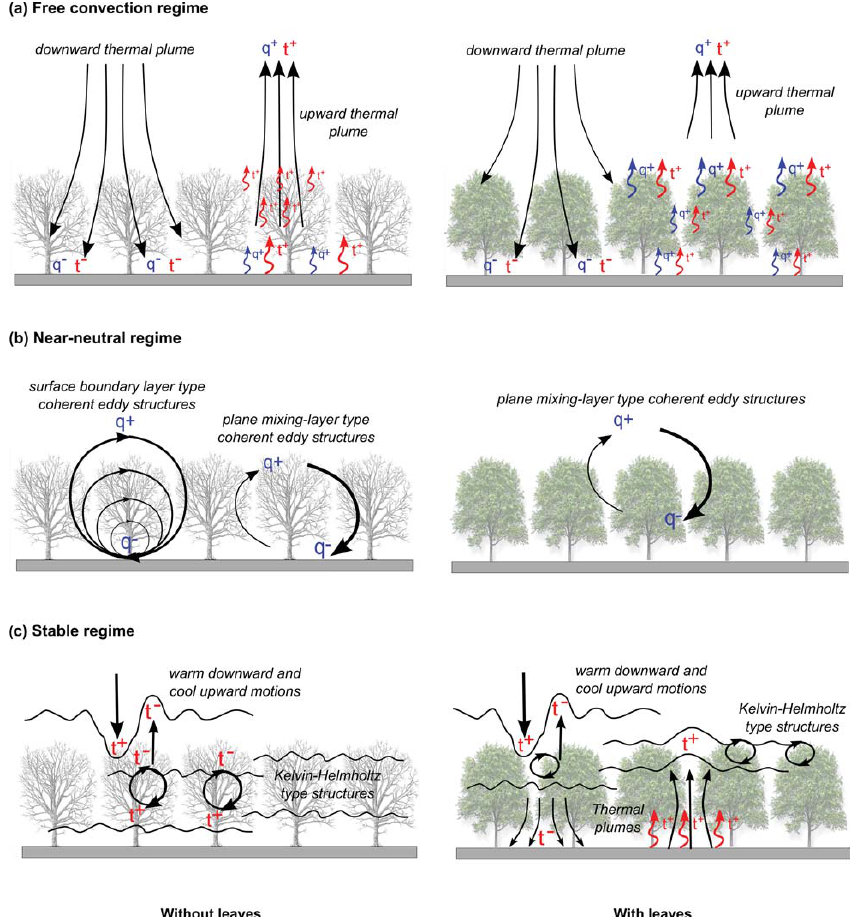
Fig. 12. Idealized representation of the turbulent structures transporting momentum and scalars (temperature t and water vapor q ) at CHATS and their main characteristics during: (a) free convection, (b) near-neutral, and (c) stable regimes for both seasonal periods (without and with